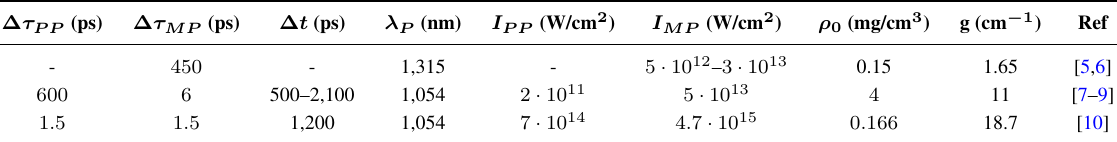
Table 1. A summary of the experimental-operating conditions in the lasing of the